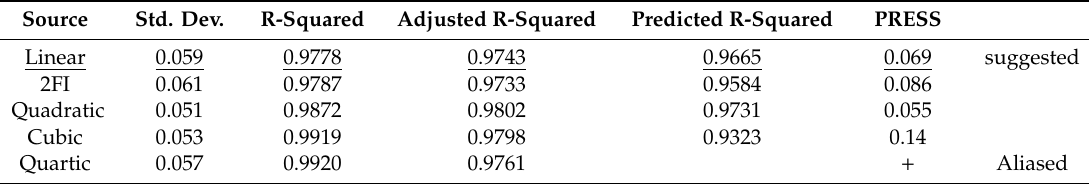
Table 10. Model summary statistics for nitrogen absorption.